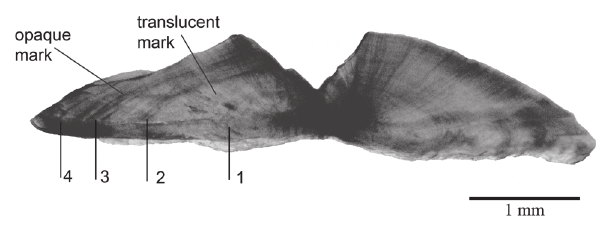
Fig. 3. Sectioned otolith of Lutjanus jocu under transmitted light showing the opaque marks (numbered rings) and translucent bands observed (Photo by M. Previero).